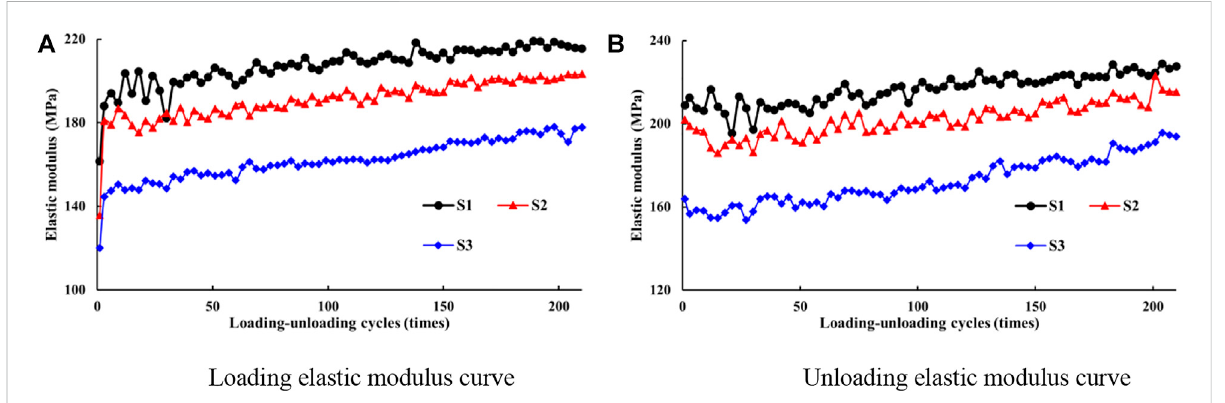
FIGURE 8 Variation of loading and unloading elastic modulus with loading-unloading cycles under different freeze-thaw conditions. (A) Loading elastic modulus curve (B) Unloading elastic modulus